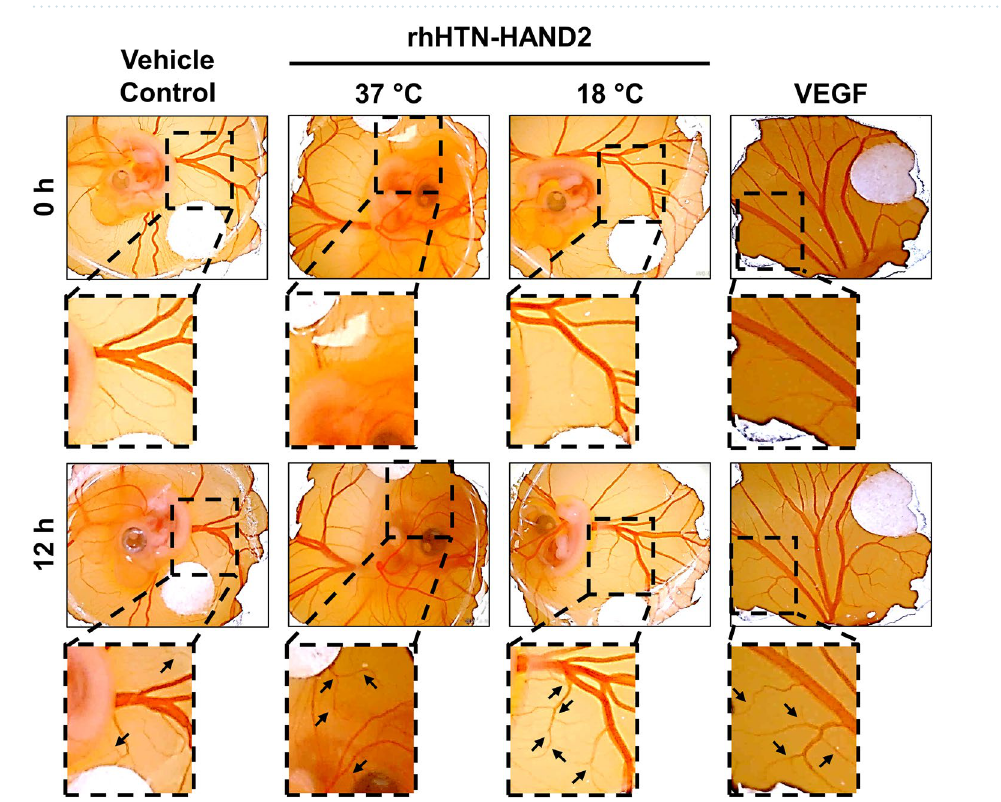
Figure 8. Examination of angiogenic potential of the purified rhHAND2 fusion protein using ex vivo chicken CAM model. Embryonated chicken eggs 3–4 days old were gently cut open on the top and treated with purified rhHTN-HAND2 protein (induced either at 37 or 18 °C) or vehicle control or VEGF (positive control) for 12 h at 37 °C. Macroscopic images of CAM were captured before and after the incubation. All images were taken with identical camera settings. Images are representative of three different